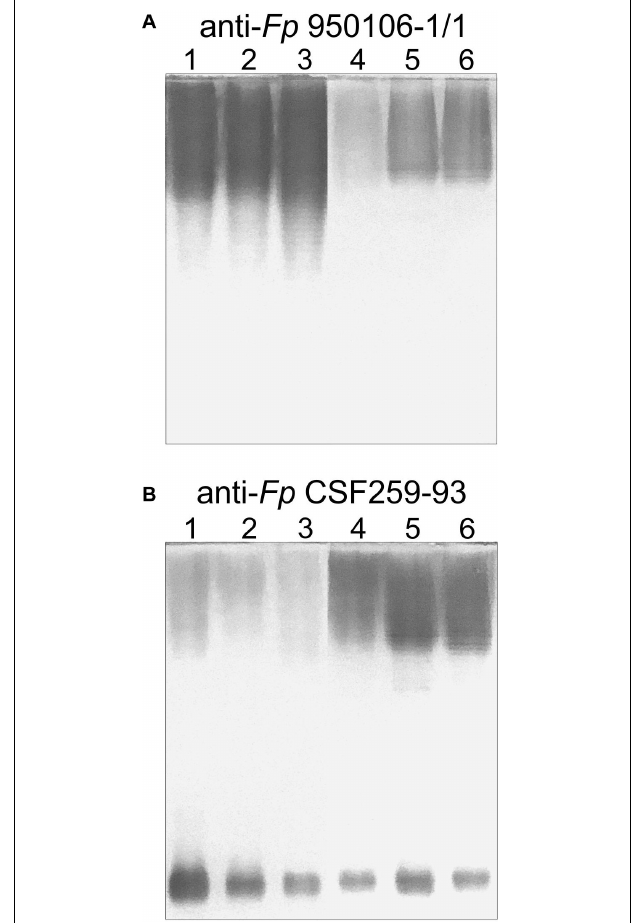
FIGURE 3 | Western blots of LPS (0.5 µ g/lane) developed with equivalent dilutions of (A) anti- Fp 950106-1/1 serum or (B) anti- Fp CSF259-93 serum. Number designations for LPS of different Fp strains are the same as in Figure 2 : (1) Fp 950106-1/1; (2) Fp 11754; (3) Fp CSF117-10; (4) Fp ARS-060-14; (5) Fp Loa-10; and (6) Fp